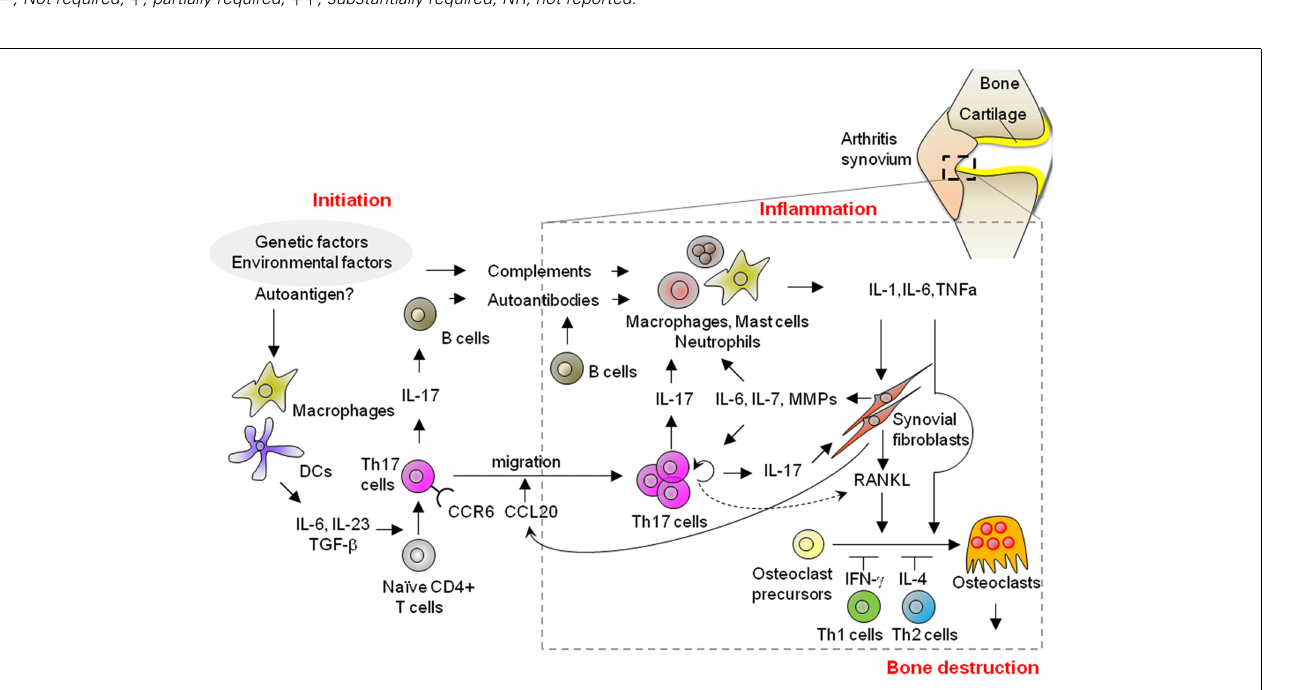
FIGURE 1 | Possible mechanisms of the initiation, inflammatory, and bone destruction phases in RA. A variety of different cell populations, including lymphocytes, innate immune cells, synovial fibroblasts, and osteoclasts, play a role in the development of RA.Th17 cells contribute to the development of arthritis in each of the initiation, inflammatory, and bone destructive phases through the production of autoantibodies